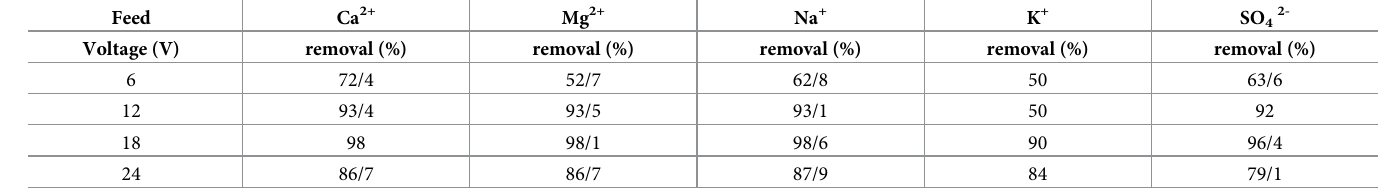
Table 3. The percentage of cation and anion removal in EDR at different voltages. (Feed flow rate = 12 L/h, water recovery ratio for TDS 6764 mg/L = 75% and the feed temperature = 14˚C). Feed